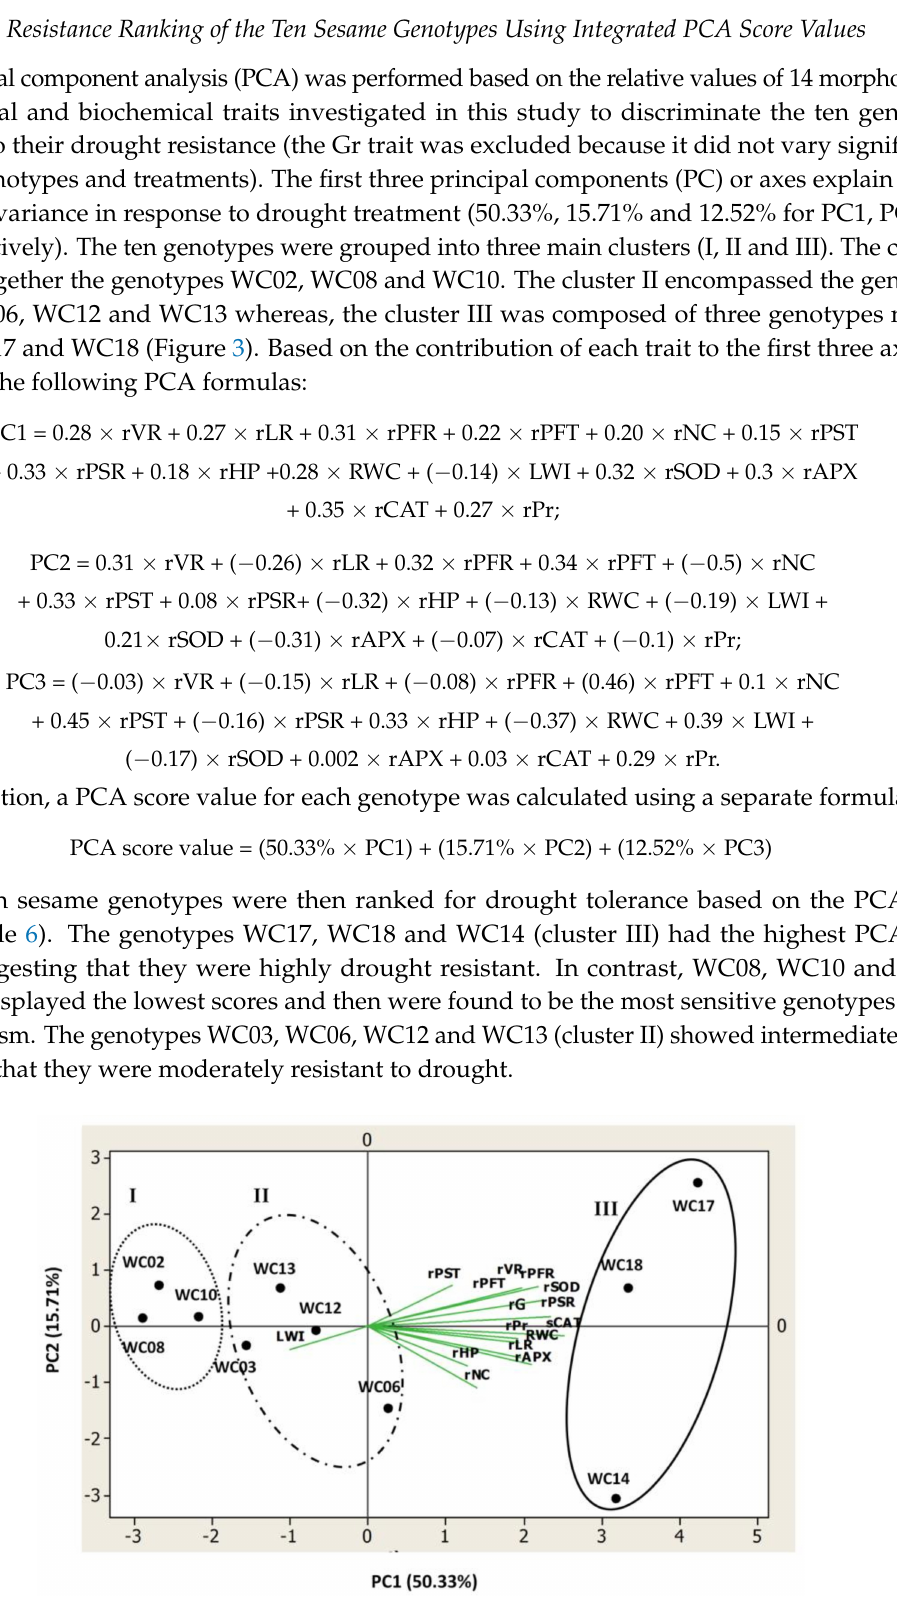
Figure 3. Loading plot obtained from principal component analysis (PCA) carried out based on 14 morphological, physiological and biochemical traits. Percentages in brackets correspond to the explained variances of corresponding components or axes. The circles represent the different